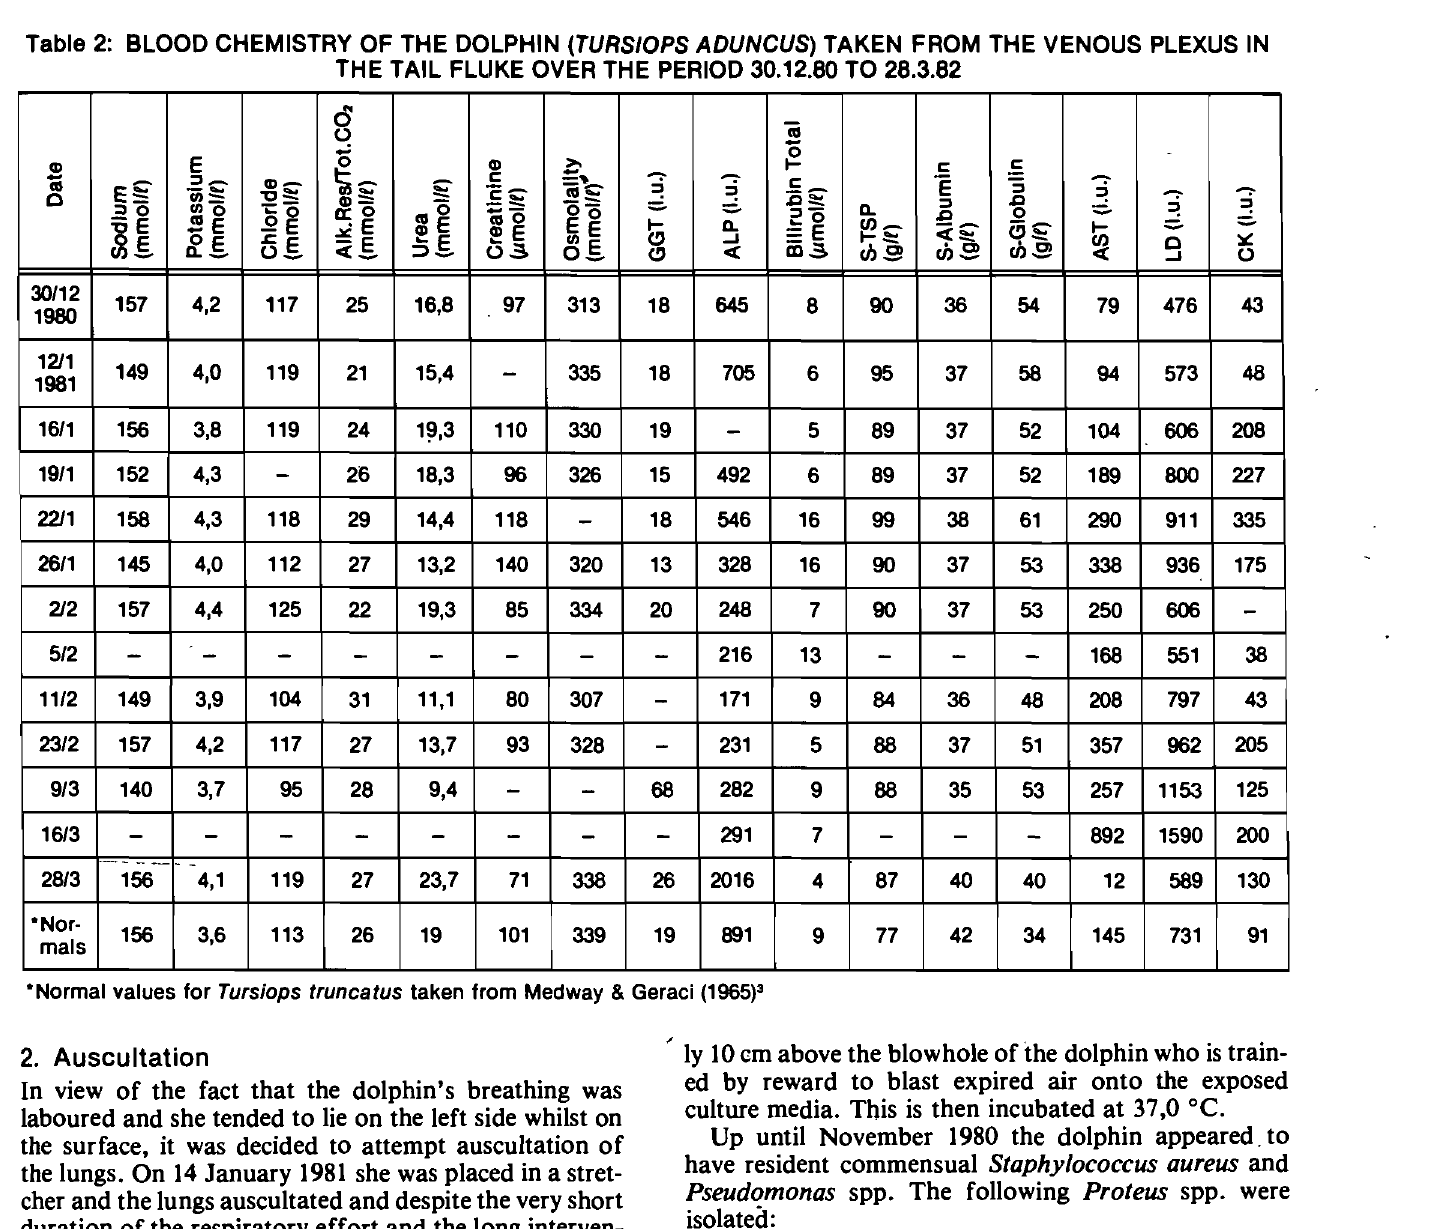
Table 2: BLOOD CHEMISTRY OF THE DOLPHIN (TURSIOPS ADUNCUS) TAKEN FROM THE VENOUS PLEXUS IN THE TAIL FLUKE OVER THE PERIOD 30.12.80 TO 28.3.82 cS